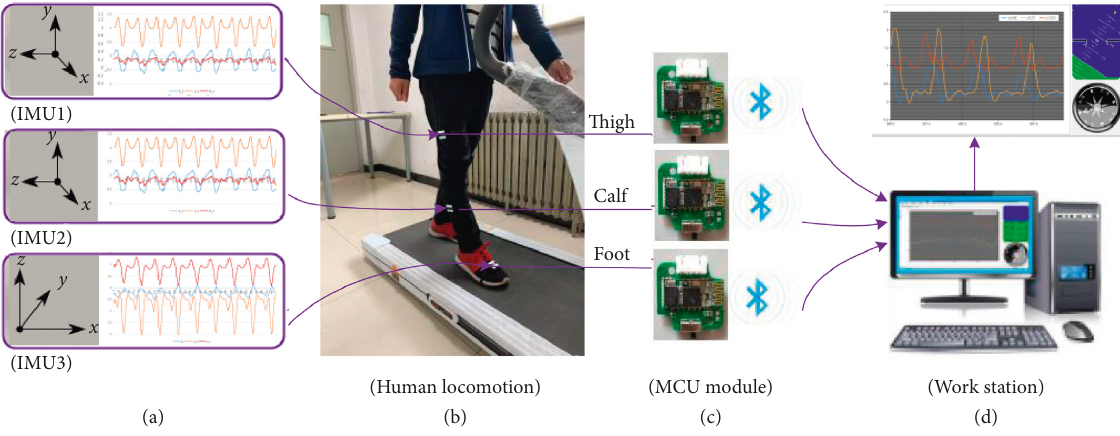
Figure 2: Human gait information acquisition system. Table 1: Acceleration data for different parts at different speeds using PCA synthesized parameter